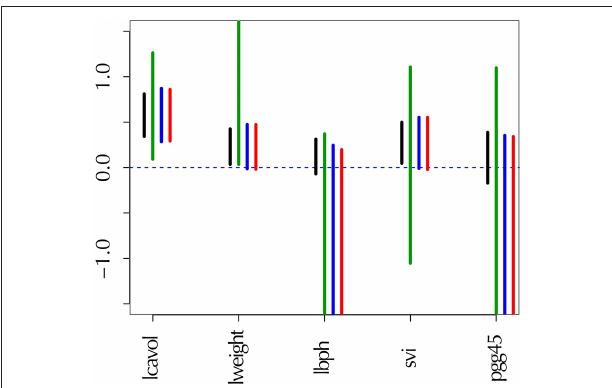
FIGURE 1 | Confidence intervals of regression coefficients for selected variables by lasso; see section 6.8 for details. All intervals are computed for confidence level 1 − α at α = 0.01. (Black) the ordinary confidence interval [ L ordinary j , U ordinary j ]. (Green) the selective confidence interval [ L model j , U model j ] under the selected model. (Blue) the selective confidence interval [ L variable j , U variable j ] under the selection event that variable j is selected. (Red) the multiscale bootstrap version of selective confidence interval [ ˆ L variable j , ˆ U variable j ] under the selection event that variable j is